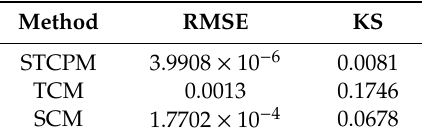
Figure 13. K-distribution fitting of real and generated clutter: ( a ) PDF; ( b ) CDF. Table 3. Statistics of methods.